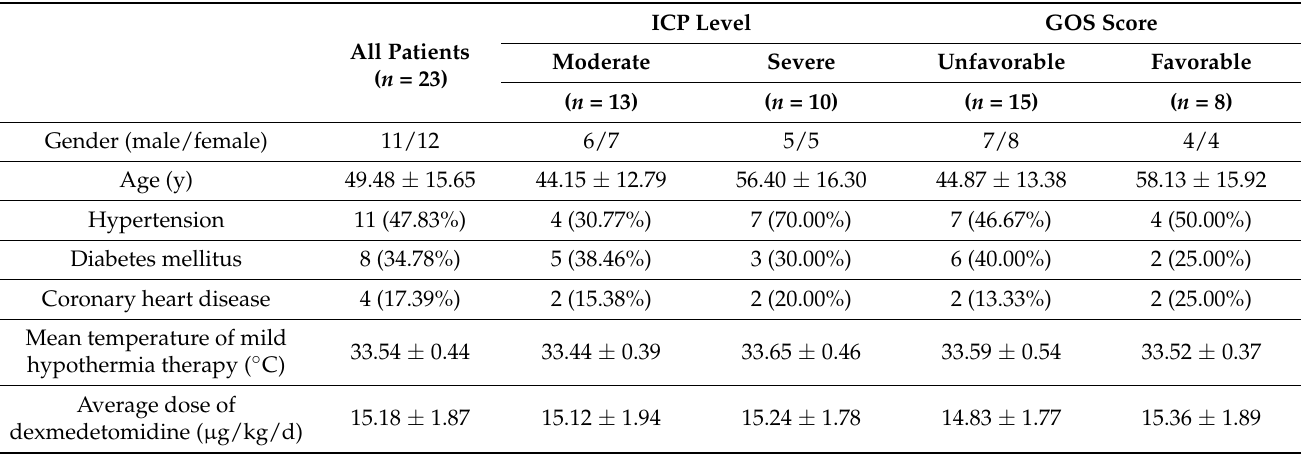
Table 2. Baseline Patient Characteristics.